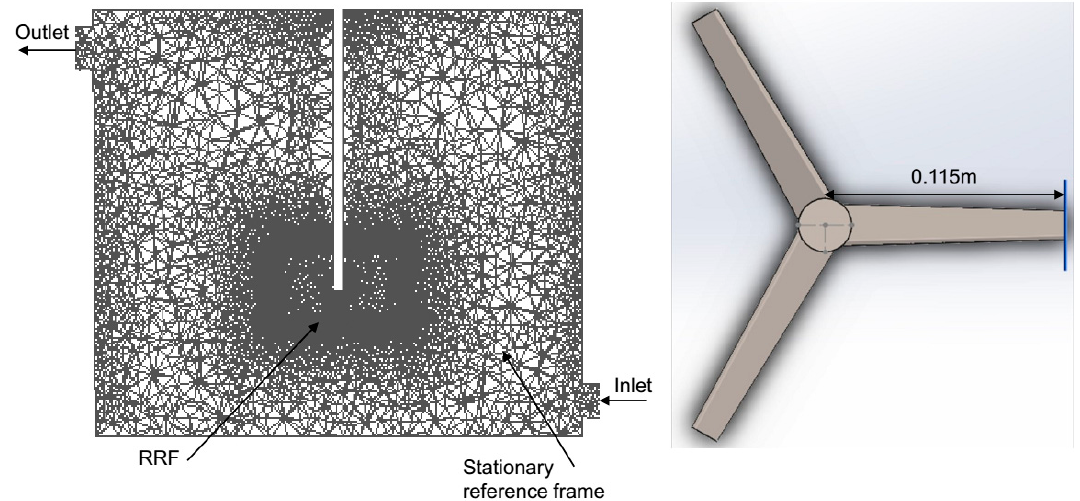
Figure 1. Geometry and mesh (left) and impeller (right) of the anaerobic digestion (AD) understudy.